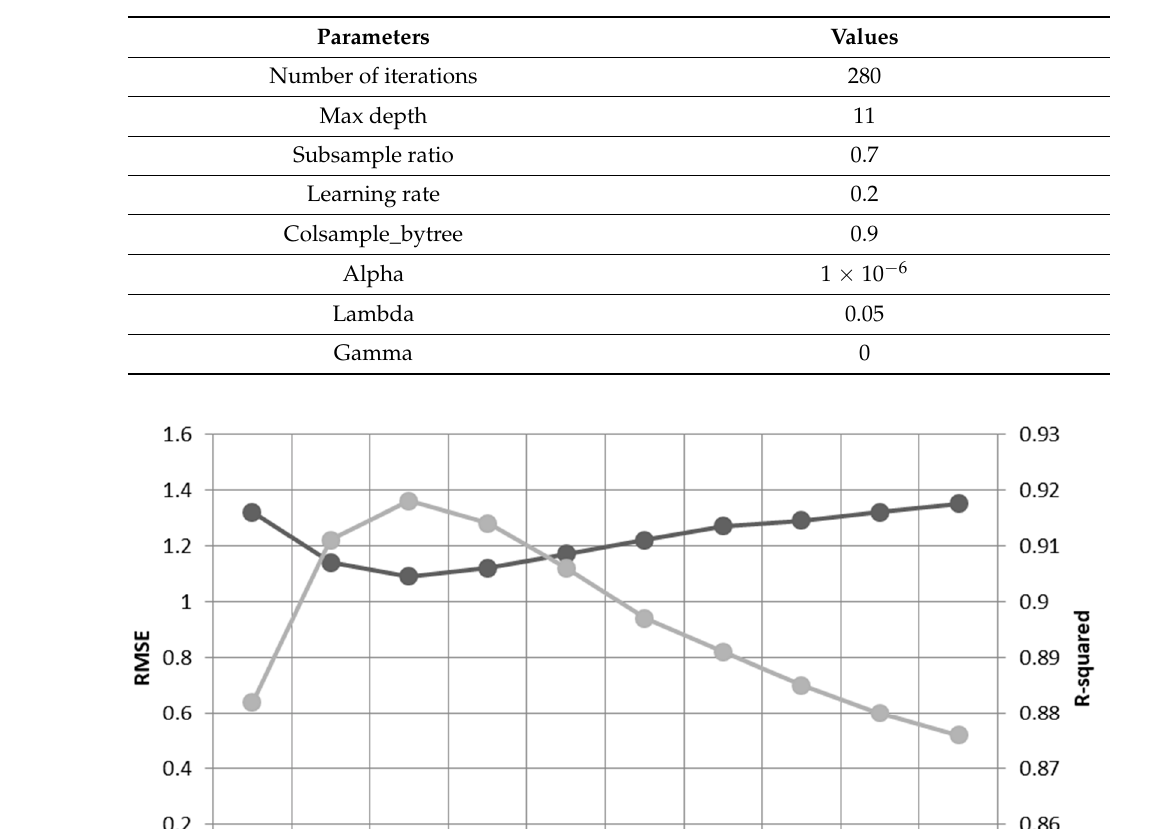
Table 3. Parameters of XGBoost model.